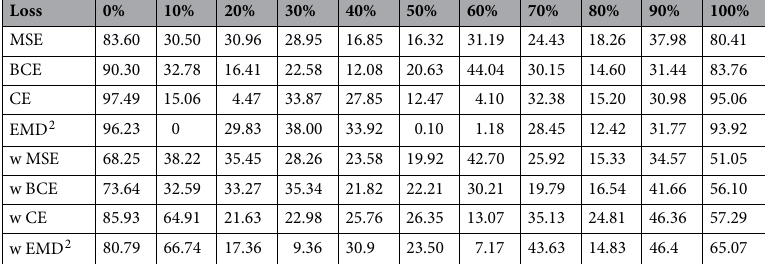
Table 2. Test accuracy values for individual classes. w indicates a weighted